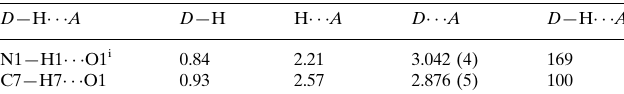
Hydrogen-bond geometry (A˚ , (cid:4)